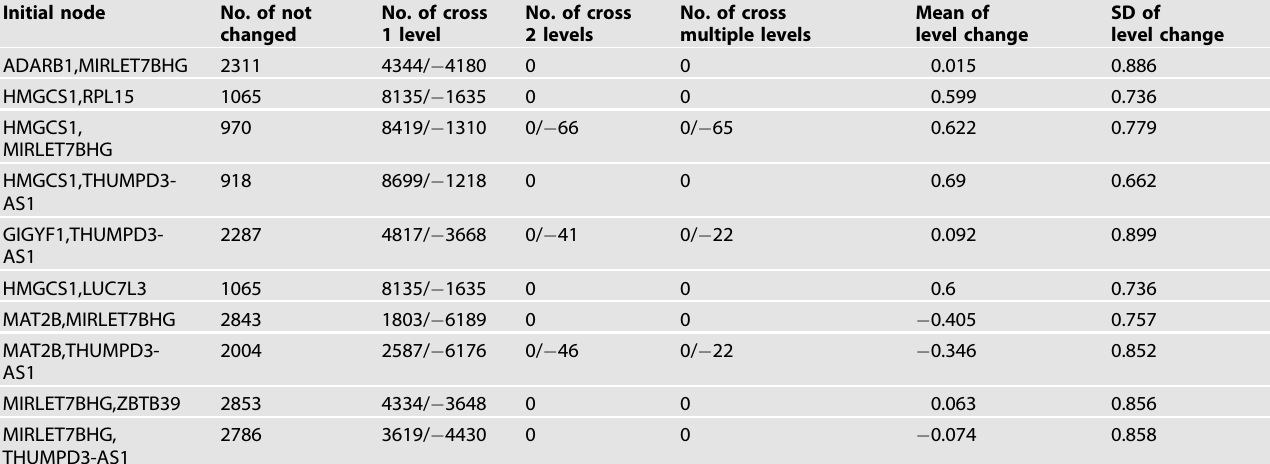
Table 1. Summary of level order changes with different initial nodes. Initial